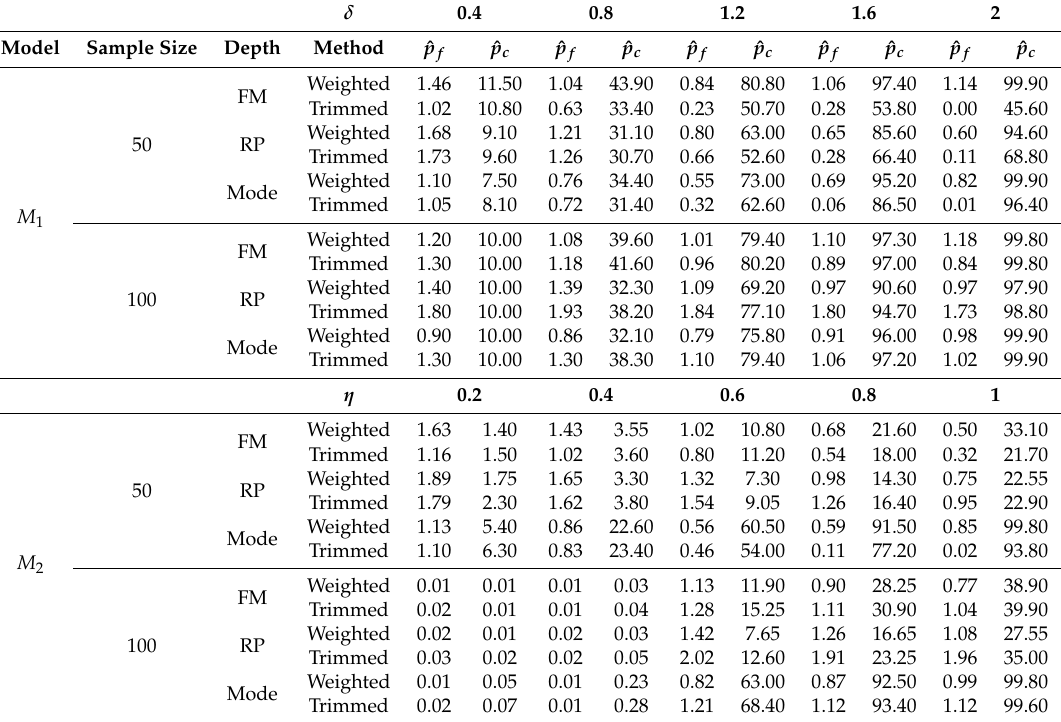
Table 5. Empirical values of ˆ p f and ˆ p c , with ρ = 0.5 (assuming dependence between